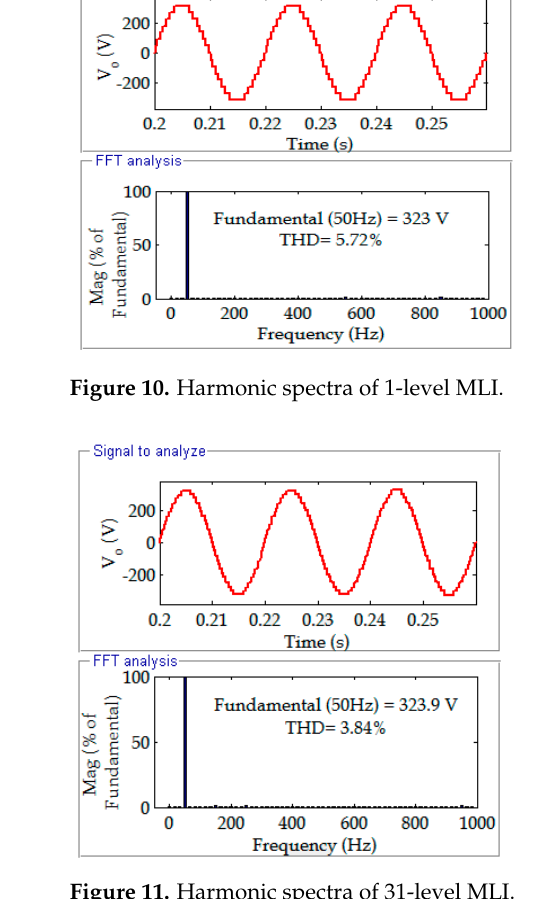
Figure 11. Harmonic spectra of 31 − level MLI.